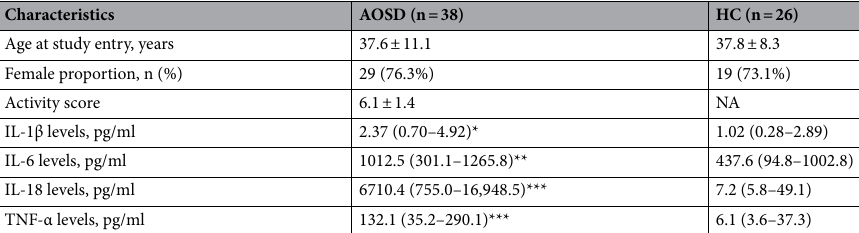
Table 1. Demographic data and laboratory findings of patients with Adult-onset Still’s disease (AOSD) and healthy controls (HC). # Data presented as mean ± SD, number (percentage), or median (interquartile range); NA: not applicable; IL: interleukin; TNF-α: tumor necrosis factor-α. * P < 0.05, ** P < 0.005, *** P < 0.001, vs. healthy controls, determined by Mann–Whitney U